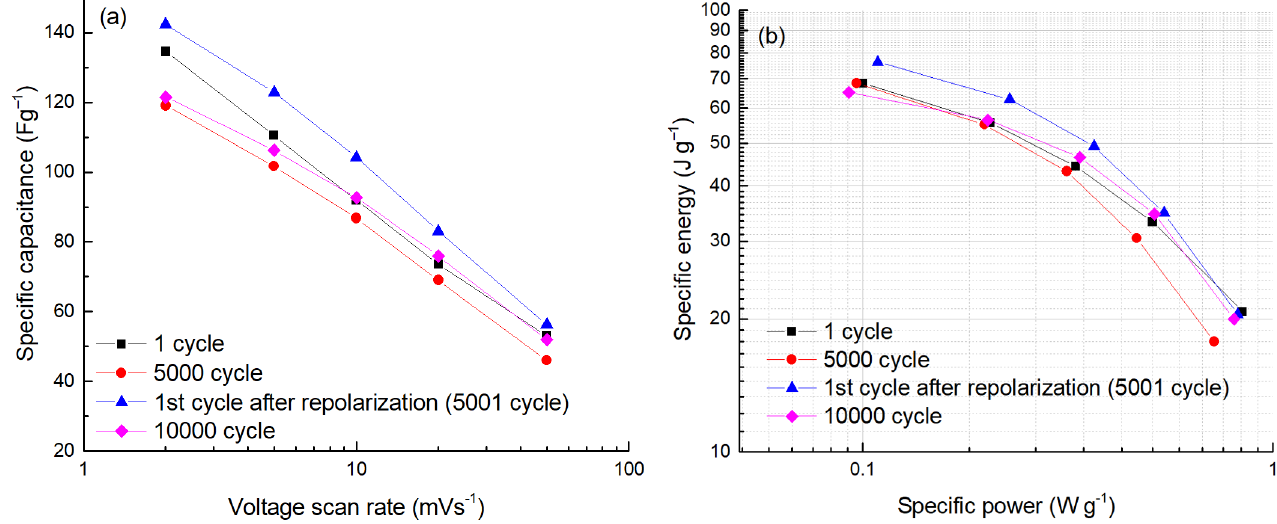
Figure 6. The dependence of specific capacitance on scan rate ( a ) and specific energy vs. specific power ( b ) measured during the cycle-life test at 1.5